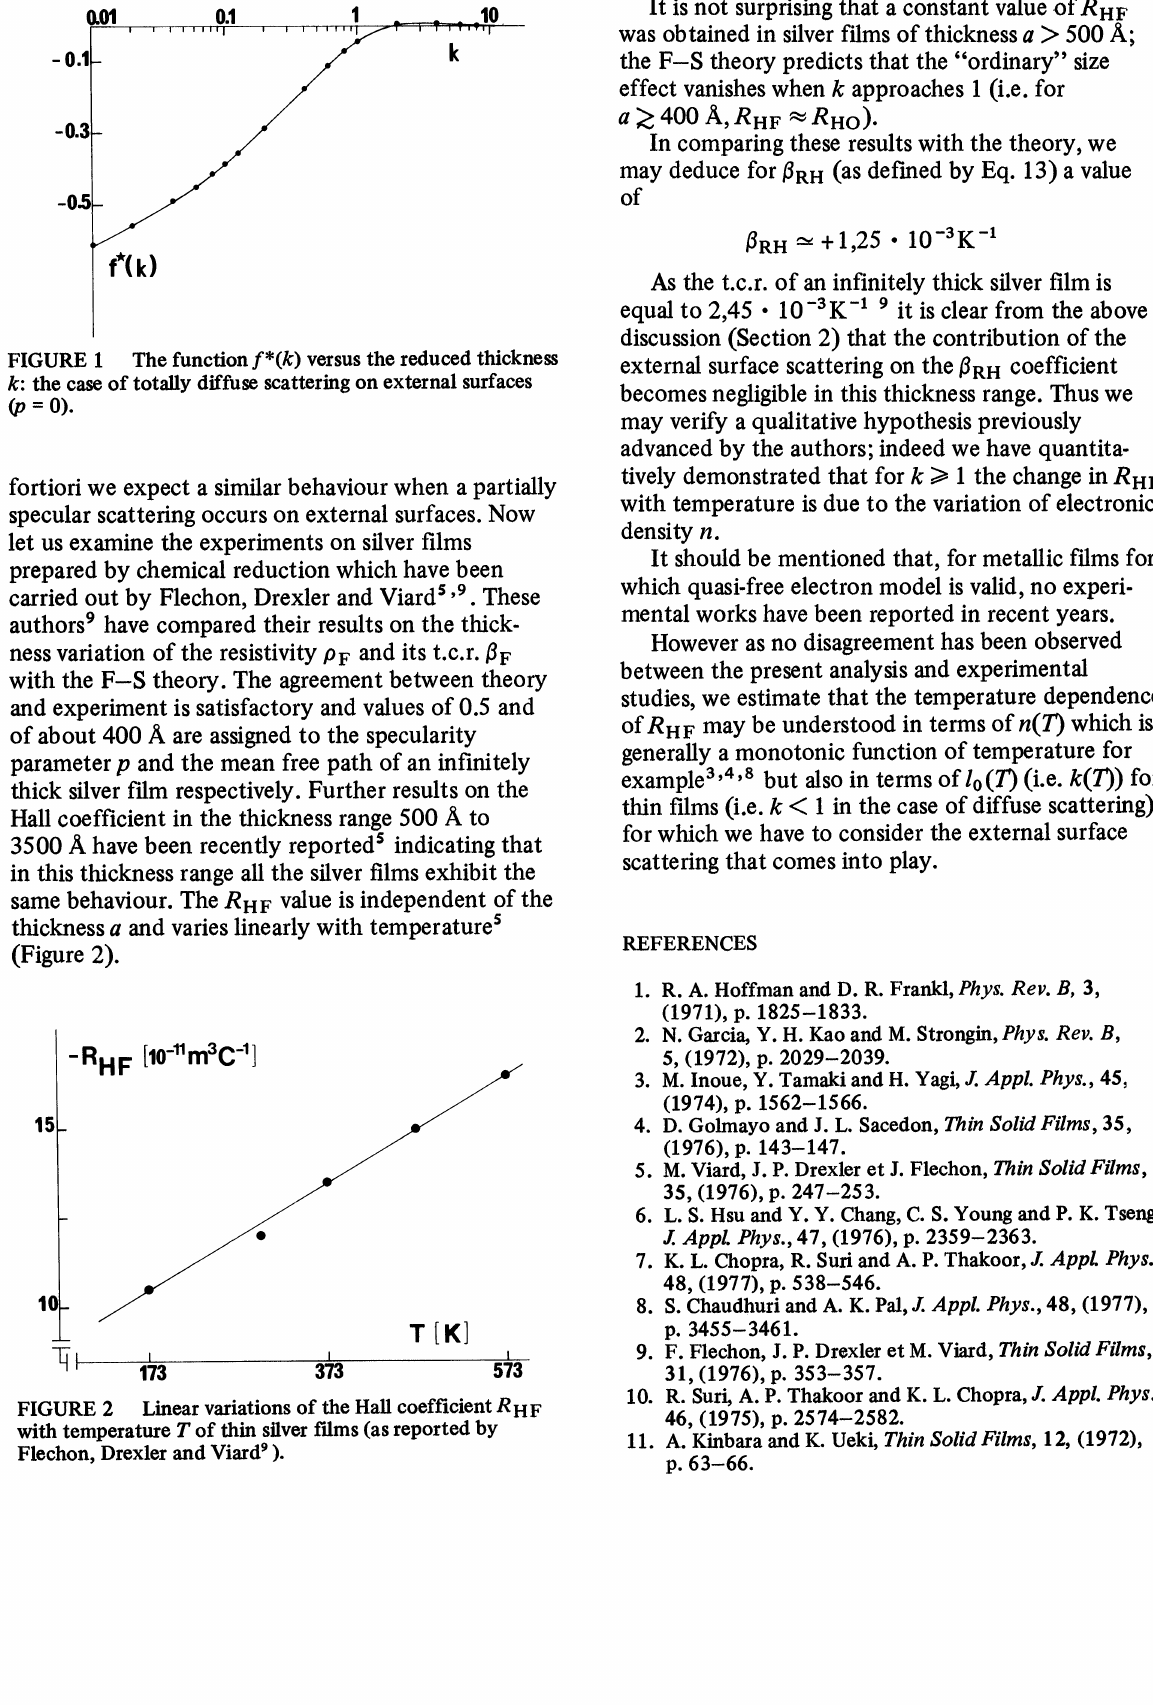
The function f*(k) versus the reduced thickness k: the ease of totally diffuse scattering on external surfaces (p =o).